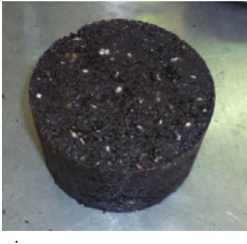
Fig. 3. Asphalt specimen Table 1. Physico-mechanical properties of asphalt specimens Compaction temperature,